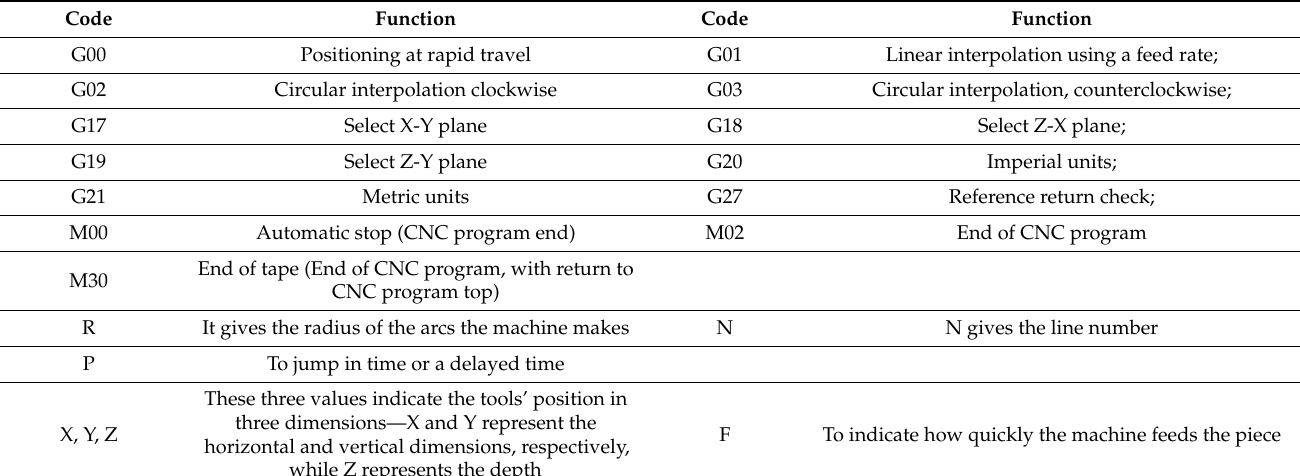
Table 4. CNC Codes list.